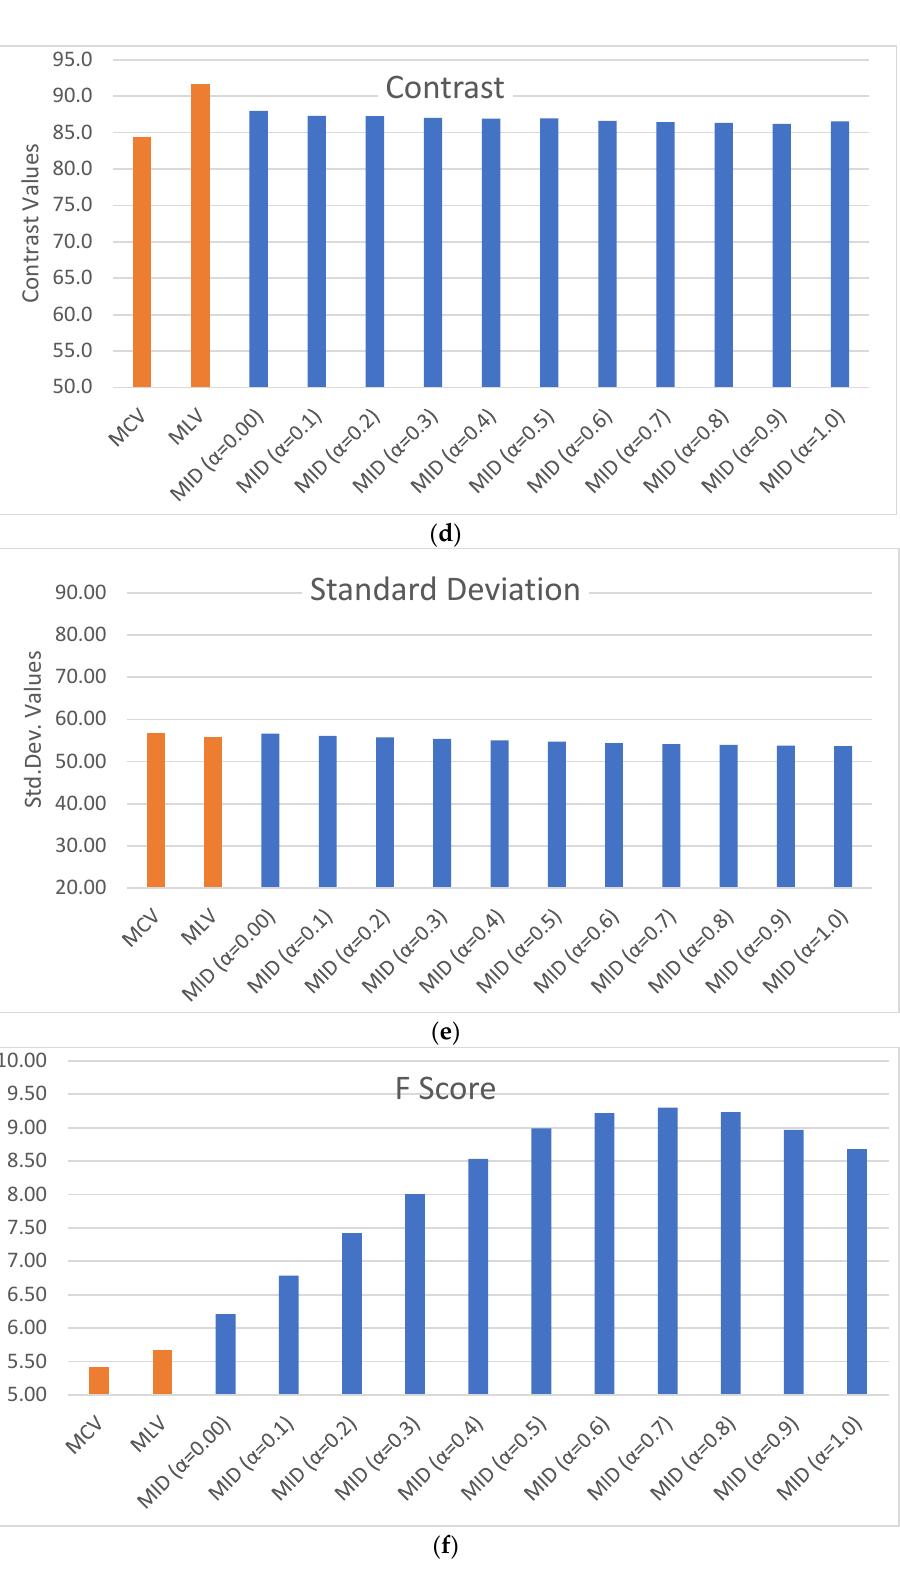
Figure 2. Average peak signal-to-noise ratio (PSNR) rates in decibel (dB) ( a ), average mean squared error (MSE) values ( b ), average structural similarity index (SSIM) rates ( c ), average contrast values ( d ), average standard deviations ( e ), and average F scores ( f ) for the gray-scale computational and subjective image quality (CSIQ) dataset.